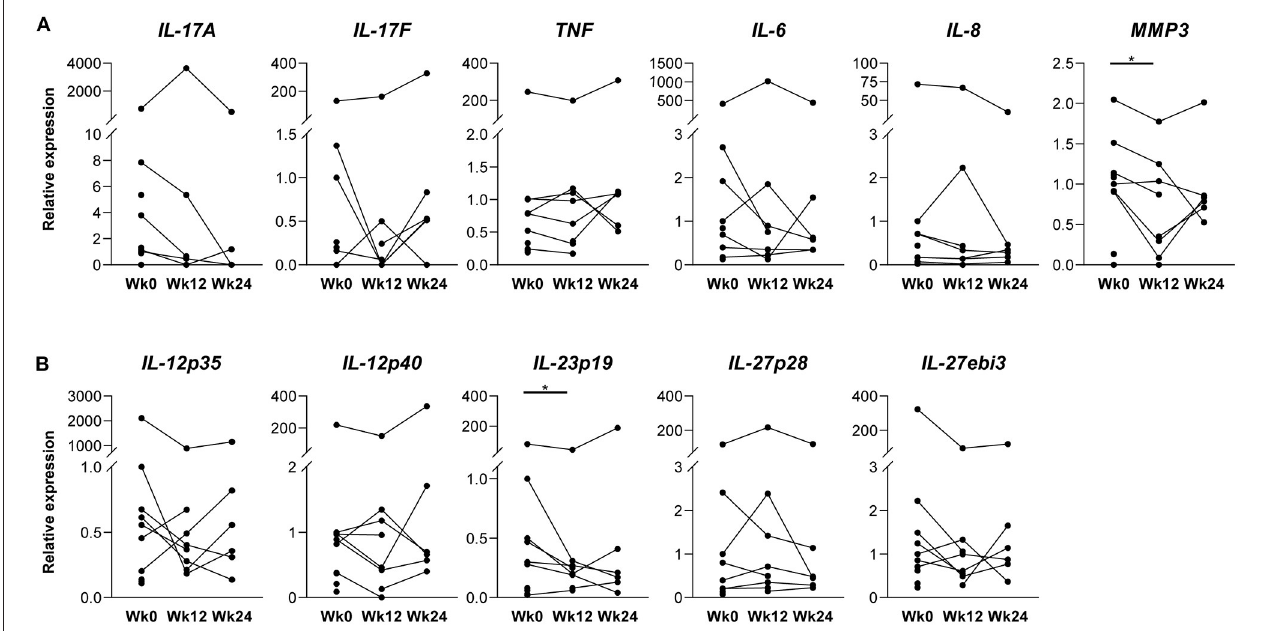
FIGURE 2 | Key inflammatory cytokines and IL-12 family member subunits in synovial tissue before and after ustekinumab treatment. mRNA levels were assessed in total synovial biopsies before (W0, n = 10) and after 12 (W12, n = 8), and 24 weeks (W24, n = 6) of ustekinumab treatment by a real-time quantitative polymerase chain reaction, normalized to the expression of GAPDH housekeeping gene and presented as fold change relative to the reference sample. (A) Relative mRNA expression of interleukin (IL)-17A, IL-17F, tumor necrosis factor (TNF), IL-6 and IL-8 show no significant alterations after ustekinumab treatment, only matrix metalloproteinase 3 (MMP3) reaches borderline significance ( p = 0.047) after 12 weeks of ustekinumab treatment. (B) Relative mRNA expression of IL-12p35, IL-12p40, IL-23p19, IL-27p28, and IL-27ebi3 show no effect of IL12-p40 blockade on mRNA expression of IL-12 family subunits, except for IL-23p19, which is significantly decreased after 12 weeks of ustekinumab treatment ( p = 0.020). * P <